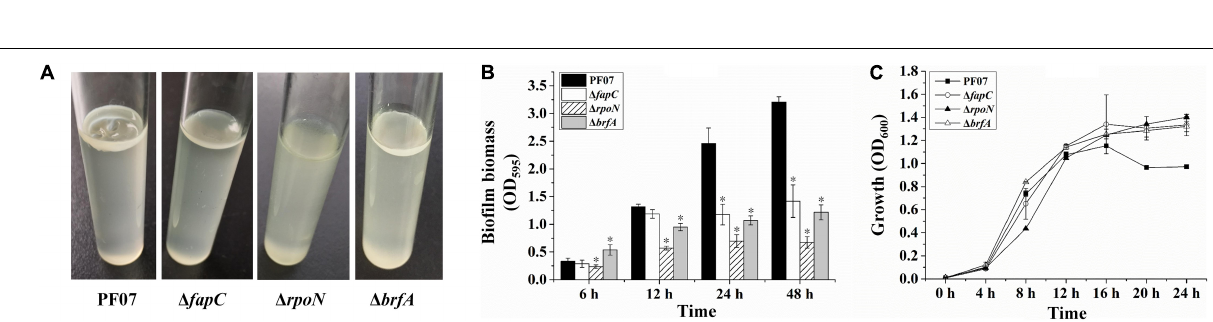
Frontiers in Microbiology |